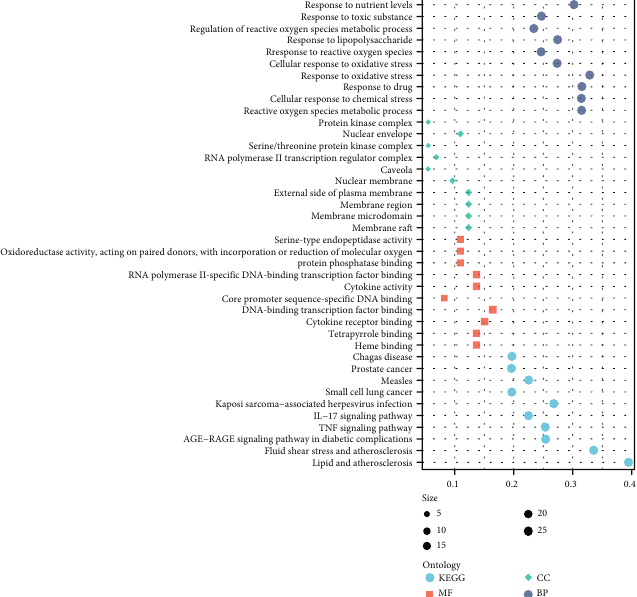
Figure 4: Results of GO and KEGG pathway